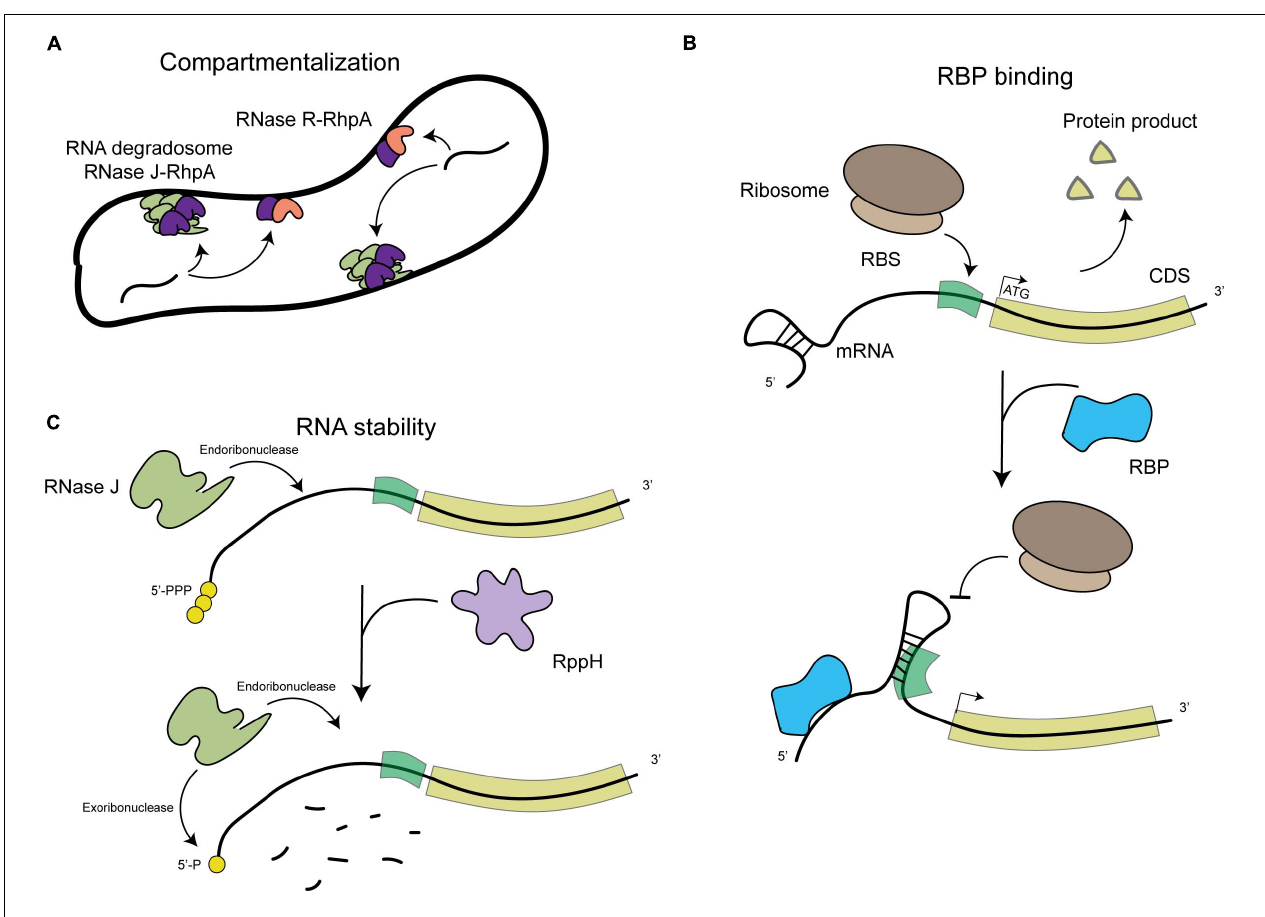
FIGURE 1 | Schematic representation of the general levels of post-transcriptional regulation in H. pylori . (A) Compartmentalization of RNA degradation, with the RNA degradosome composed of RNAse J (in green) and RhpA (in pink) localizing into foci at the inner membrane and the RNase R (in dark purple)-RhpA complex also binding the inner membrane. (B) RNA binding protein (RBP)-mediated regulation, where binding of an RBP (in blue) can cause a structural rearrangement in the RNA molecule that allows or prevents the expression of the proteins it encodes. (C) RNA degradation by both endo- and exoribonucleases, such as RNase J (in light green), which also depends on the phosphorylation state of the 5 (cid:48) -end of the mRNA molecules (RppH in light